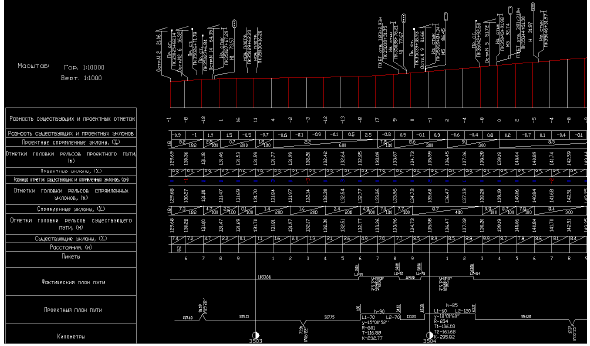
Figure 11. The example of a longitudinal